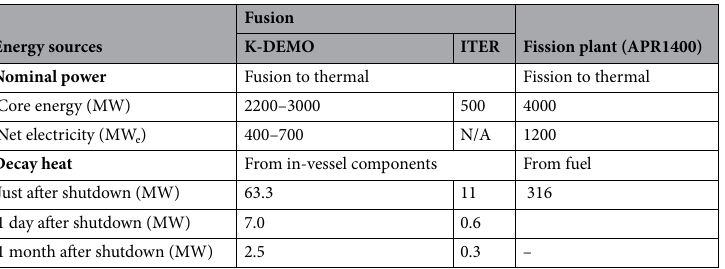
Table 2. Nominal power and decay heat evaluation for K-DEMO and a comparison with ITER and a commercial nuclear power plant (APR1400 model).